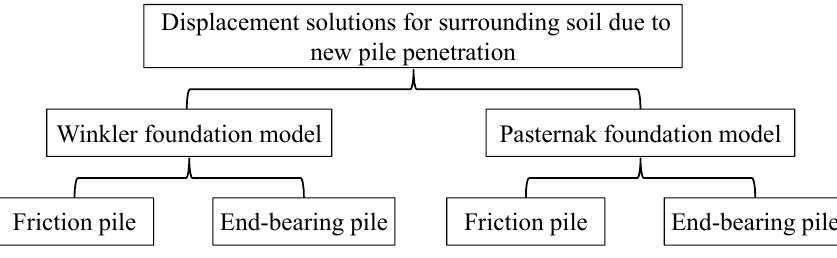
Figure 3. Analysis workflow of stress and deformation of used piles.